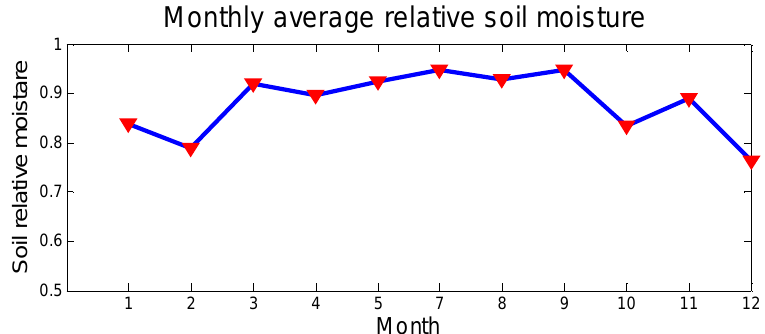
Figure 3. Average relative soil moisture in Guangxi in each month of 2017